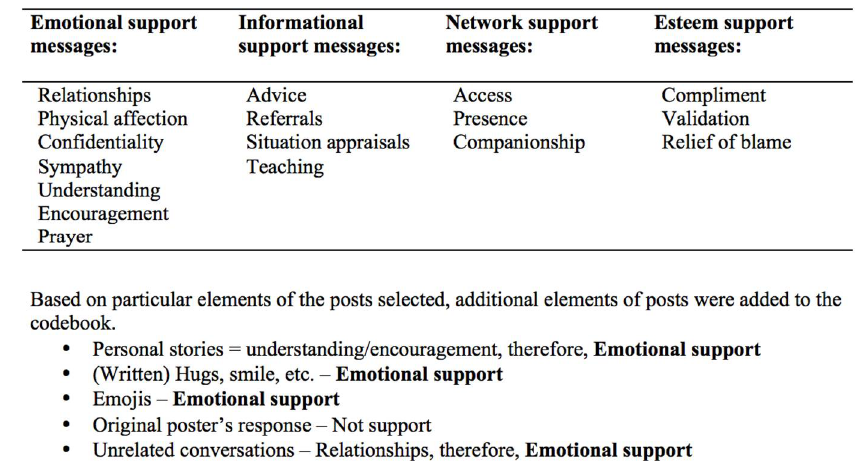
Figure A3. Codebook for types of social support based on Braithwaite et al. (1999).